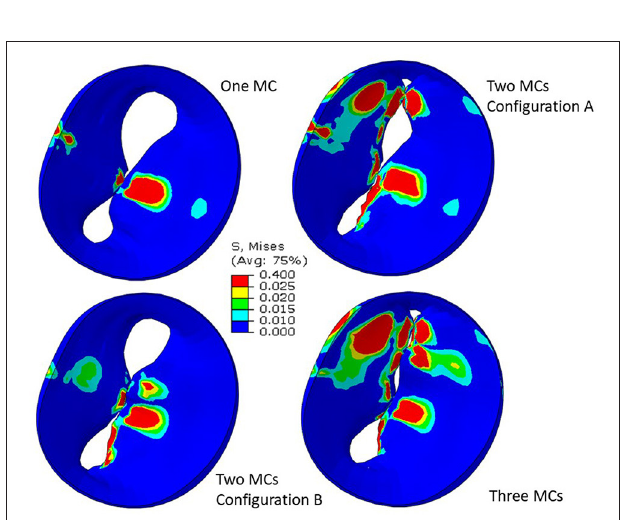
FIGURE 11 | Leaflet von Mises stresses for one, two, and three MCs. These figures show the implantation of the MC. For two clips, (A) represents clips at locations 3 and 4, and (B) represents clips at locations 3 and